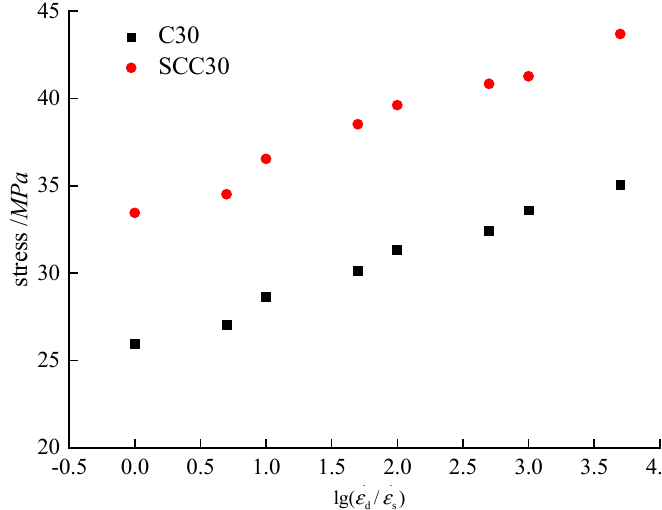
Figure 8. Relationship between strain rate and peak compressive stress.